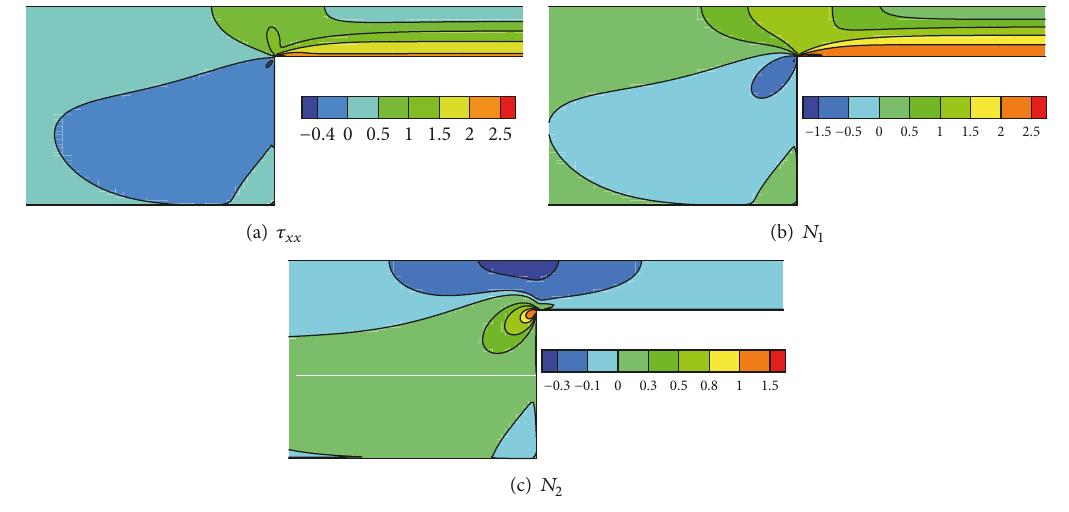
Figure 2: Stress contours near the reentrant corner.